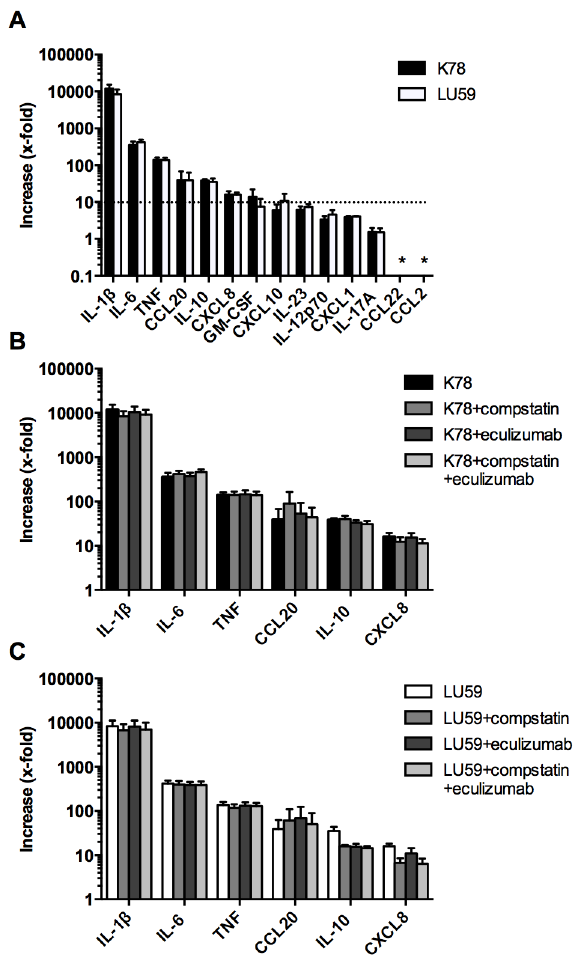
Figure 3. Cytokine and chemokine levels in plasma as a response to incubation with Borrelia spirochetes. Spirochetes were incubated in whole blood (n=3) in duplicate for 4 h, and the cytokine/chemokine production was then measured using a Luminex- based assay. Results are normalized against the values for plasma without the addition of bacteria. (A) The x-fold increase in the panel of cytokines and chemokines analyzed in this report showed no difference between the complement-resistant B. afzelii K78 and -sensitive B. garinii LU59. (B and C) The importance of complement activation was further investigated using two complement inhibitors: compstatin, which selectively inhibits the proteolytic activation of C3, and eculizumab, an anti-C5 antibody blocking the cleavage of C5 and therefore further complement activation and C5a mediated signaling. Data are presented as means 6